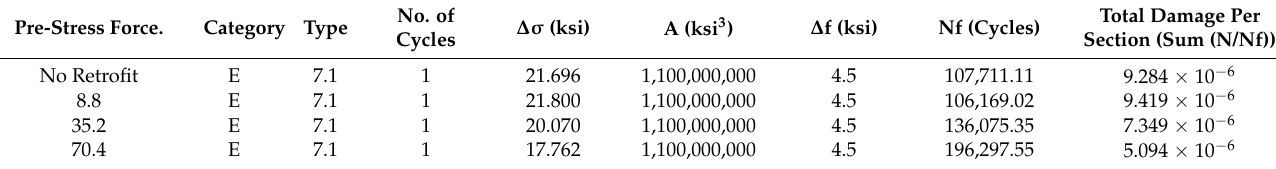
Table 3. AASHTO life-cycle fatigue from model data.